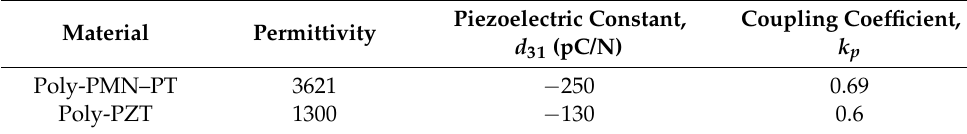
Table 1. Comparison between PZT and PMN–PT.